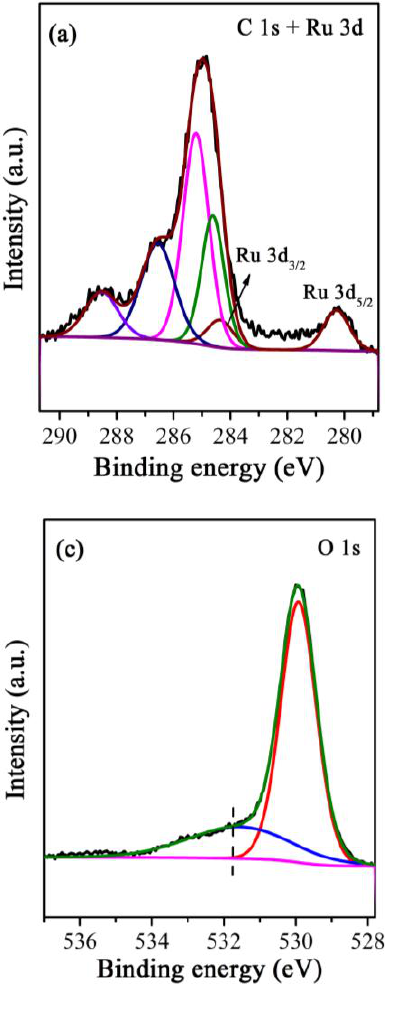
Figure 4. X-ray photoelectron spectroscopy (XPS) spectra of Ag-I-RuO 2 -O-THS: ( a ) C 1s and Ru 3d; ( b ) Ag 3d; ( c ) O 1s; ( d ) Ti 2p.